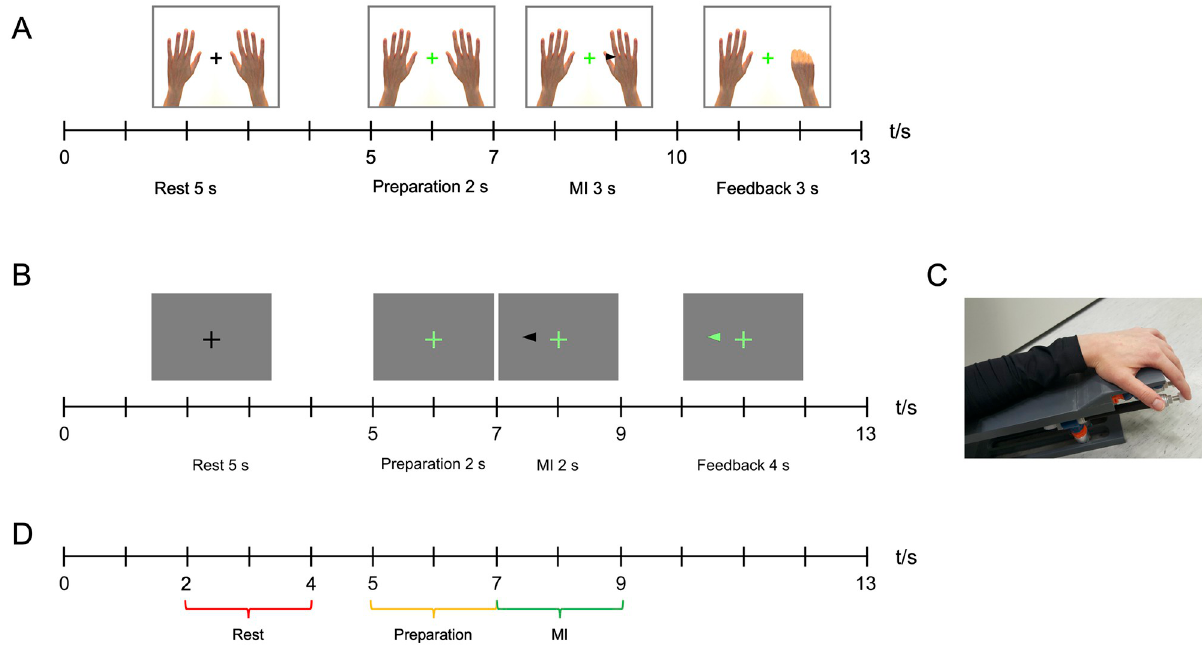
Fig 1. Stimulus paradigms. Stimulus paradigms in (A) Data 1 and (B) Data 2, and (C) the proprioceptive stimulator used in collecting Data 2. The time windows (D) used for data analyses. 7 discrete prolate spheroidal sequence (DPSS) windows and a bandwidth of 1 Hz. 50 most rele-